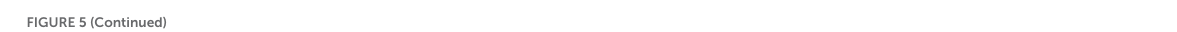
for HIF1 α , WGA, and Topro3 to quantify HIF1 α positive cardiomyocytes (c) . Values are presented as mean ± SEM with n = 18 (uninfected) and 5-6 (SARS-CoV-2 infected hamsters). Data were analyzed using a one-way ANOVA followed by a Dunnett’s multiple comparison test with * p < 0.05, *** p < 0.001 comparing 4 dpi and 14 dpi hamsters to age-matched uninfected hamsters. (d,e) Freshly isolated cardiomyocytes (d) and Vero E6 cells (e) were infected with the SARS-CoV-2 virus at a concentration of 0.2 TCID 50 per cell for 20h and subsequently treated with 800 µ M CoCl 2 for 6h in vitro . Cells were stained for HIF1 α and Topro3 to analyse the translocation of HIF1 α in a hypoxic environment. (f) Total RNA was isolated from infected hamster hearts at 4 dpi and RNA levels for SLC2A1 , SLC2A4 , HSP70 .1, HSP70 .2, and VEGFA were analyzed by RT-qPCR. Values are presented as mean ± SEM with n = 5–6. Statistical analysis was performed using a two-tailed students t -test. CoCl 2 , Cobalt Chloride; HIF1 α , Hypoxia Inducible Factor 1 α ; HSP70, Heat Shock protein 70; SLC2A1, Solute Carrier Family 2 Member 1; SLC2A4, Solute